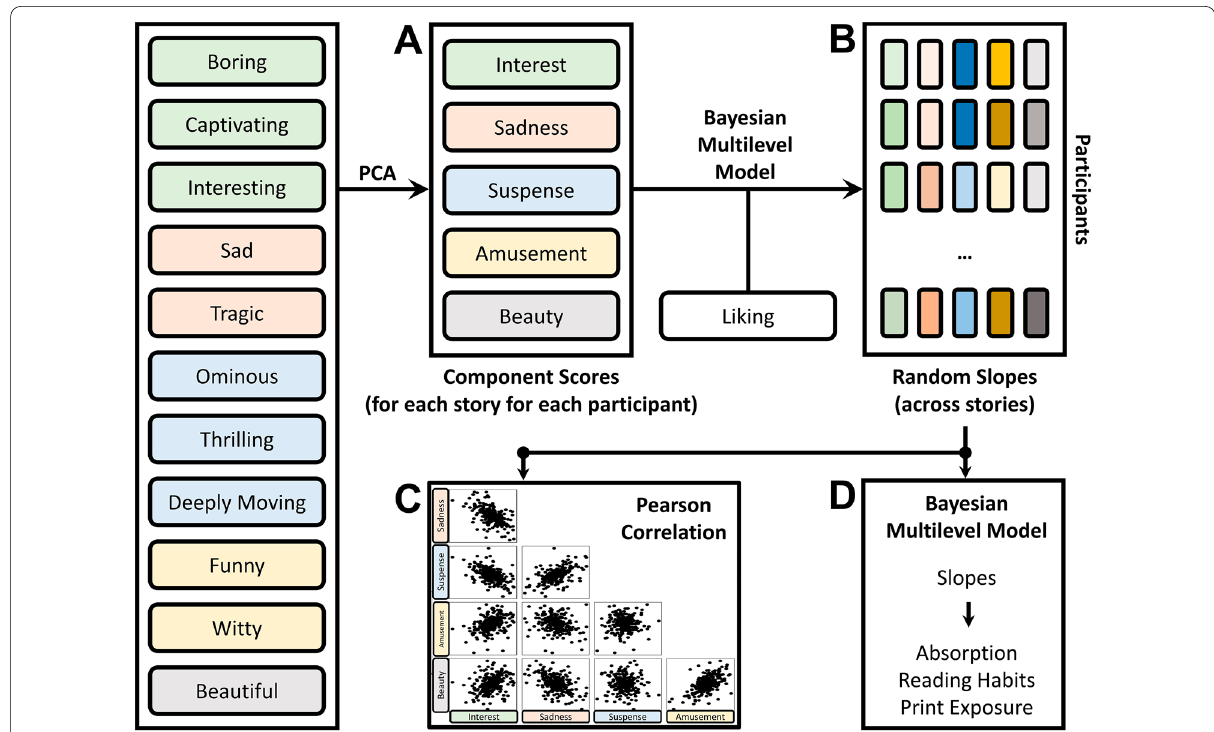
Fig. 1 Visualization of the Analysis Pipeline. Note The arrows indicate the order of processing